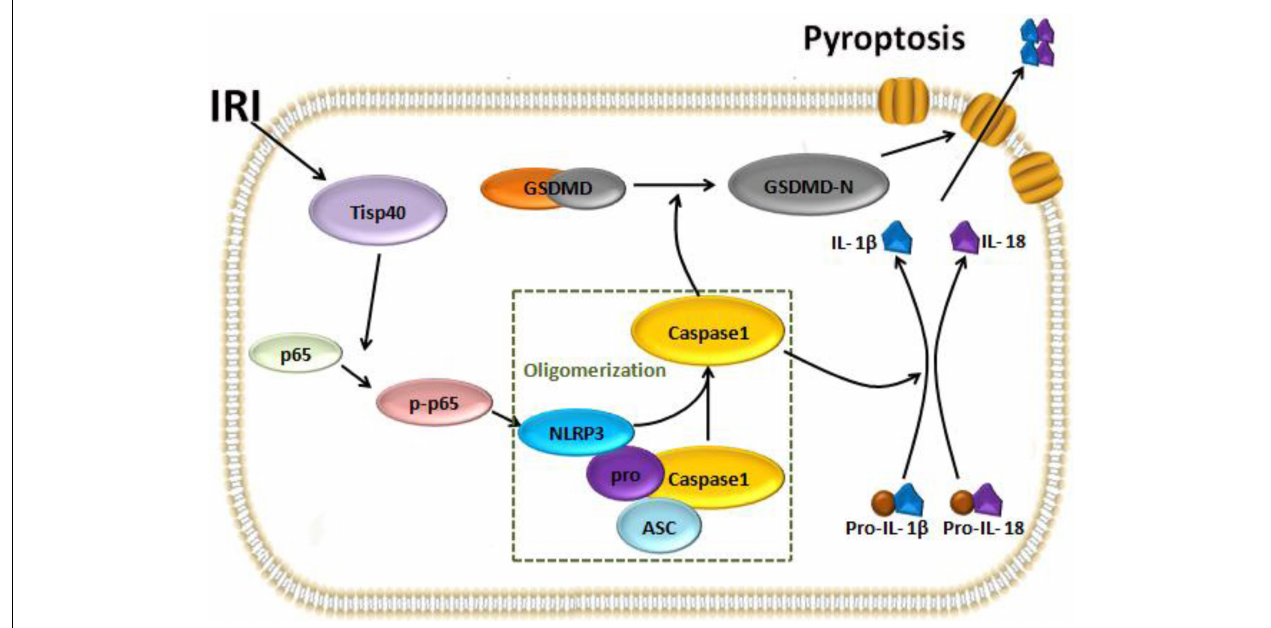
FIGURE 8 | The pathway that Tisp40 regulates Ischemia-reperfusion induced pyroptosis in